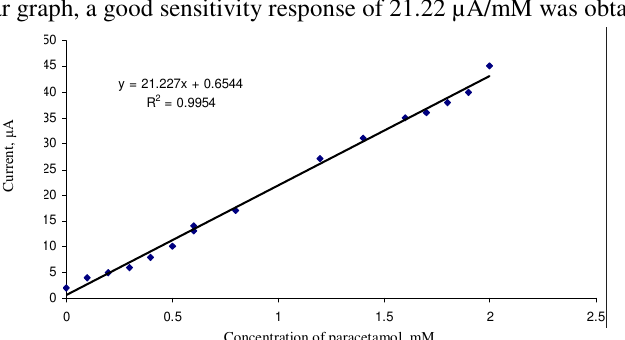
Figure 3 . A plot showing the dependence of the oxidation current on different concentration of paracetamol MgB /GC in 0.1 M KH PO solution with a scan rate of 100 2 2 4